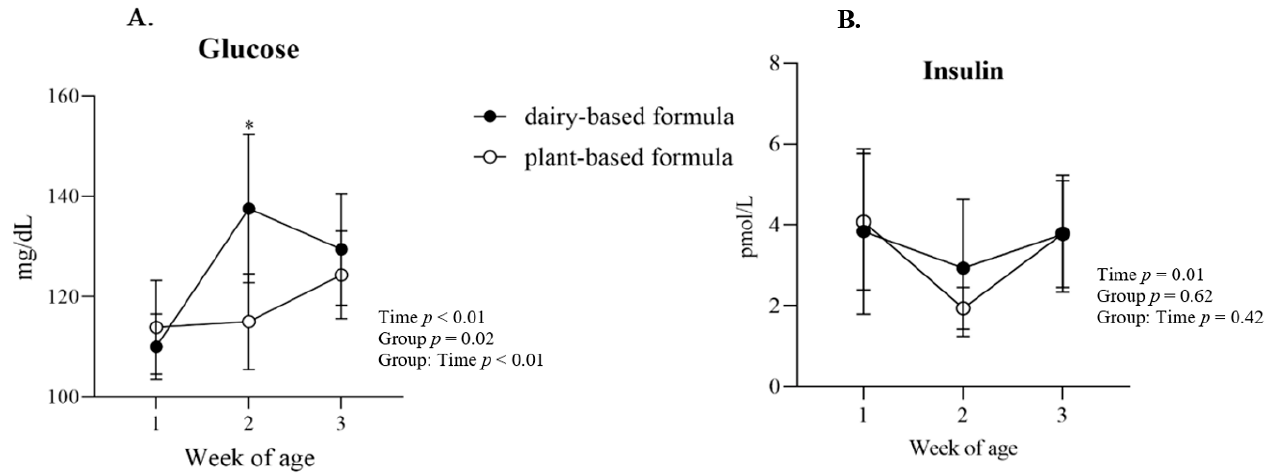
Figure 4. ( A ) Plasma glucose and ( B ) insulin (average per group) at 1, 2, and 3 weeks of age of piglets fed either a dairy-based (Similac Advance powder) or a plant-based (Else nutrition powder) formula ( n = 9/group) from postnatal day (PND) 2 until PND 21. * Represents the statistical difference between diet groups at the given time point.